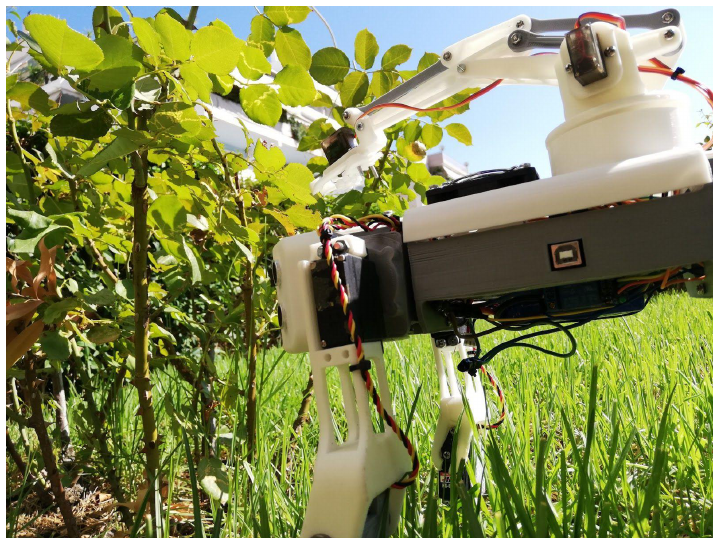
Figure 2. The ground roaming